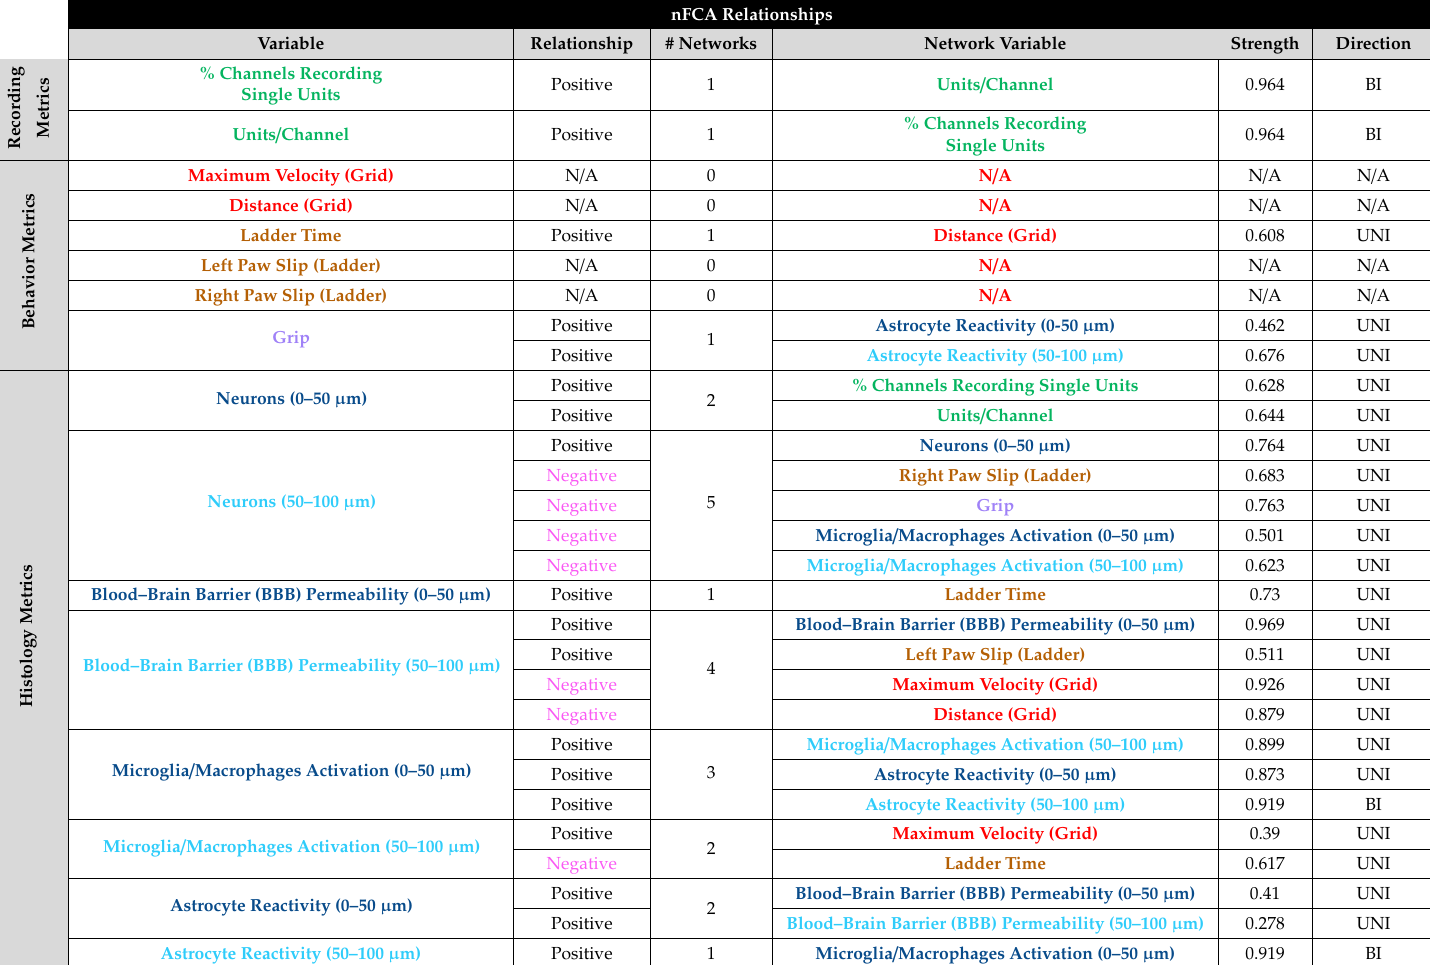
Table 2. nFCA Relationships between all Measured Variables. The table below depicts the 16 variables investigated in this study within the three metrics of interest: recording, behavior, and histology. The type of relationship (i.e., positive or negative), number of networks and specific network variables associated, and the strength and direction of that relationship are all summarized below. The color scheme in the table is uniform to that of Figure 4. n =